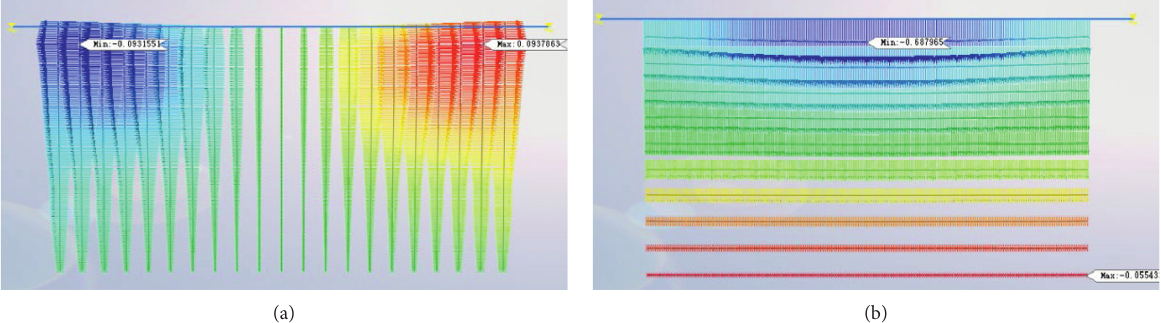
Figure 6: Displacement vector diagram of drainage plate: (a) PVDs and (b) PHDs.